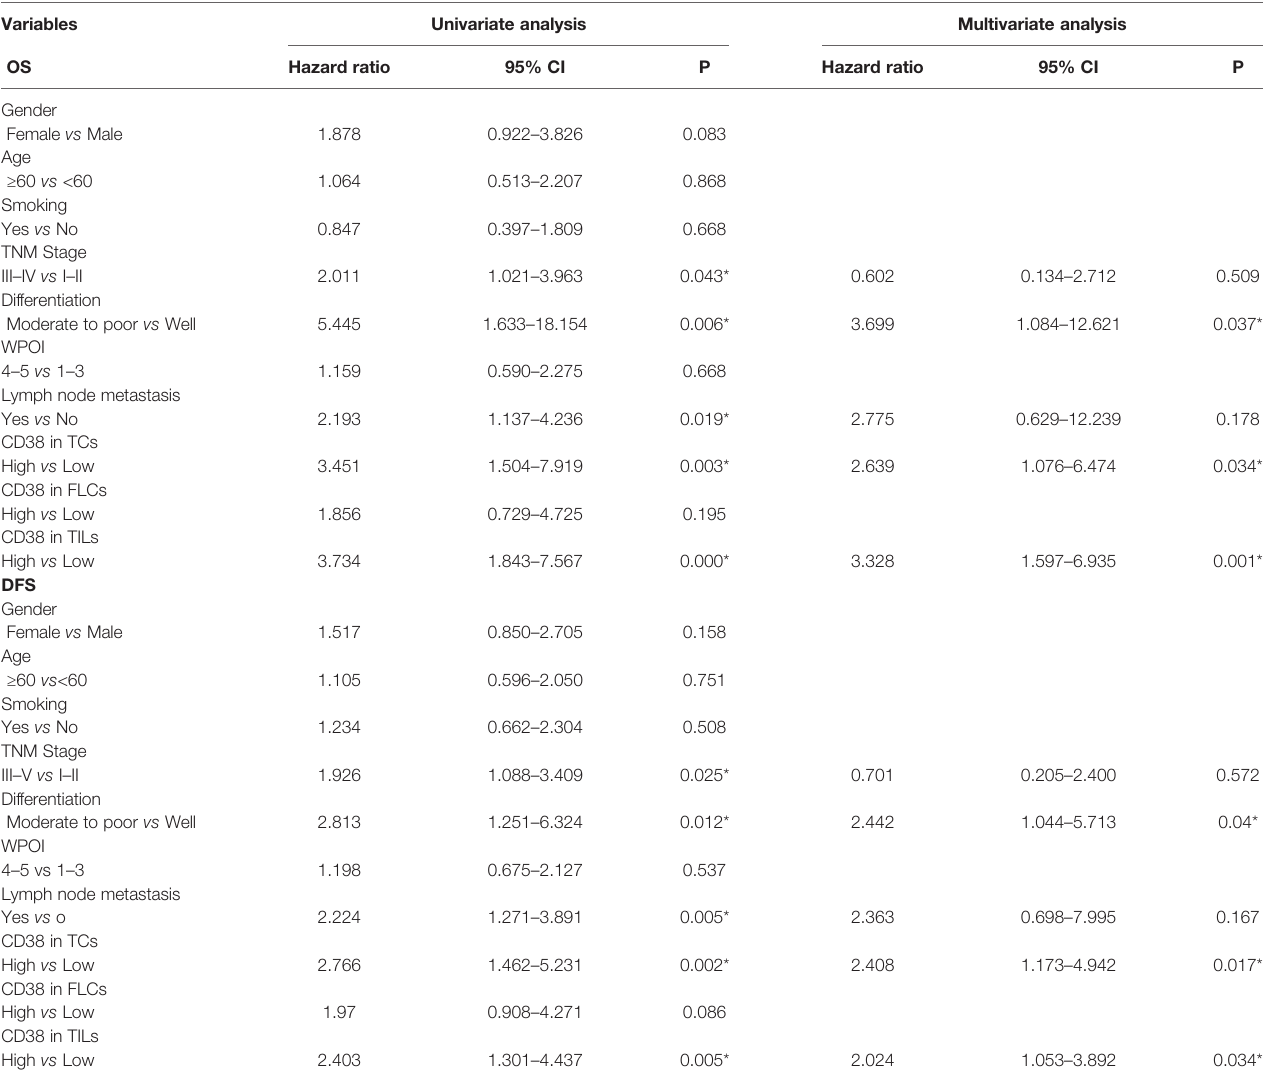
TABLE 2 | Cox-regression analysis of OS and DFS in OSCC patients. Variables Univariate analysis Multivariate